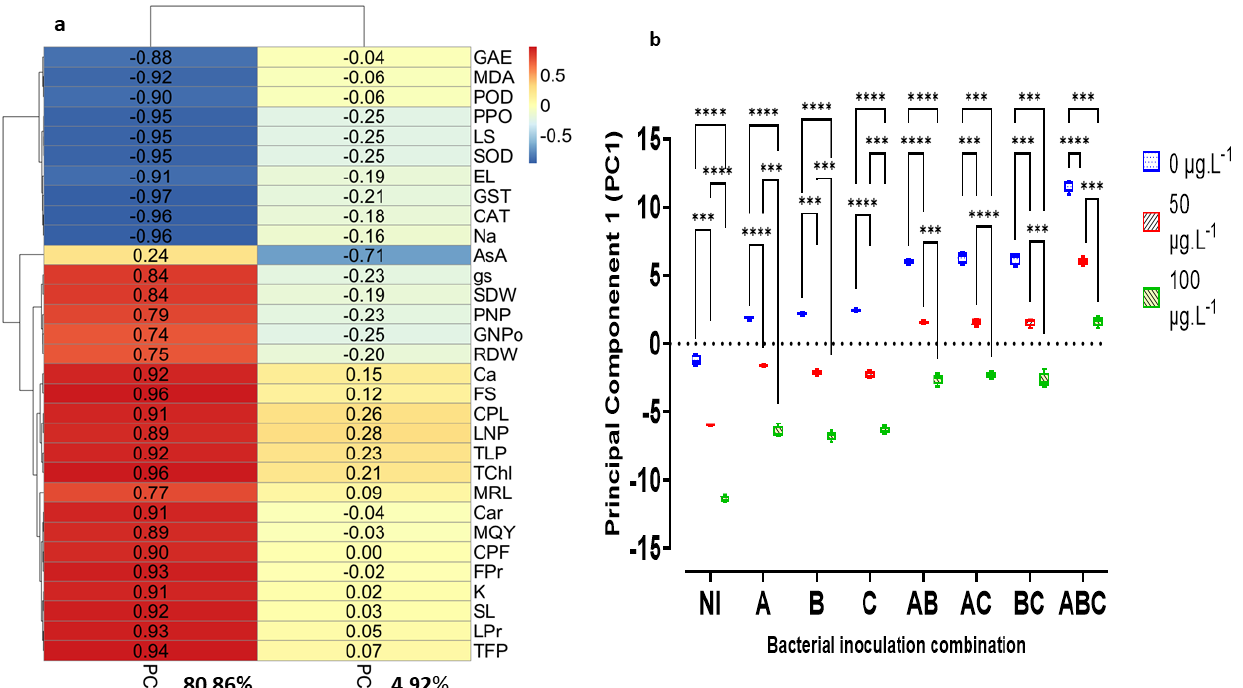
Figure 7. Heatmap ( a ) of the first two principal components, PC1 and PC2, capturing 85.78% of the variation expressed by the 31 variables studied. The values inside the map correspond to the positive and negative correlations of the different variables with respect to the Principal Components 1 and 2. Variables are defined as: stem length (SL), leaves number per plant (LNP), main root length (MRL), pod number per plant (PNP), grain number per pod (GNPo), shoot dry weight (SDW), root dry weight, stomatal conductance (gs), maximum quantum yield (MQY), total chlorophyll (TChl), carotenoids (Car), ascorbic acid (AsA), total fruit phosphorus content (TFP), total leaf phosphorus content (TLP), catalases (CAT), glutathione transferases (GST), polyphenol oxidase (PPO), peroxidase (POD) polyphenols (GAE), electrolyte leakage (EL), malondialdehyde (MDA), leaf soluble sugars (LS), fruit soluble sugars (FS), leaf soluble proteins (LPr), superoxide dismutase (SOD), calcium content in fruits (Ca), potassium content in fruits (K), sodium content in fruits (Na), crude protein content in leaves (CPL), and crude protein content in fruits (CPL); and general visualization ( b ) of the negative impact of MC and the overall gain promoted by bacterial addition on the overall pea condition by projecting MC contaminations and bacterial additions onto the first principal component. The stars correspond to statistical significance at different levels as ns= not significant; *** = p < 0.001; **** = p < 0.0001.